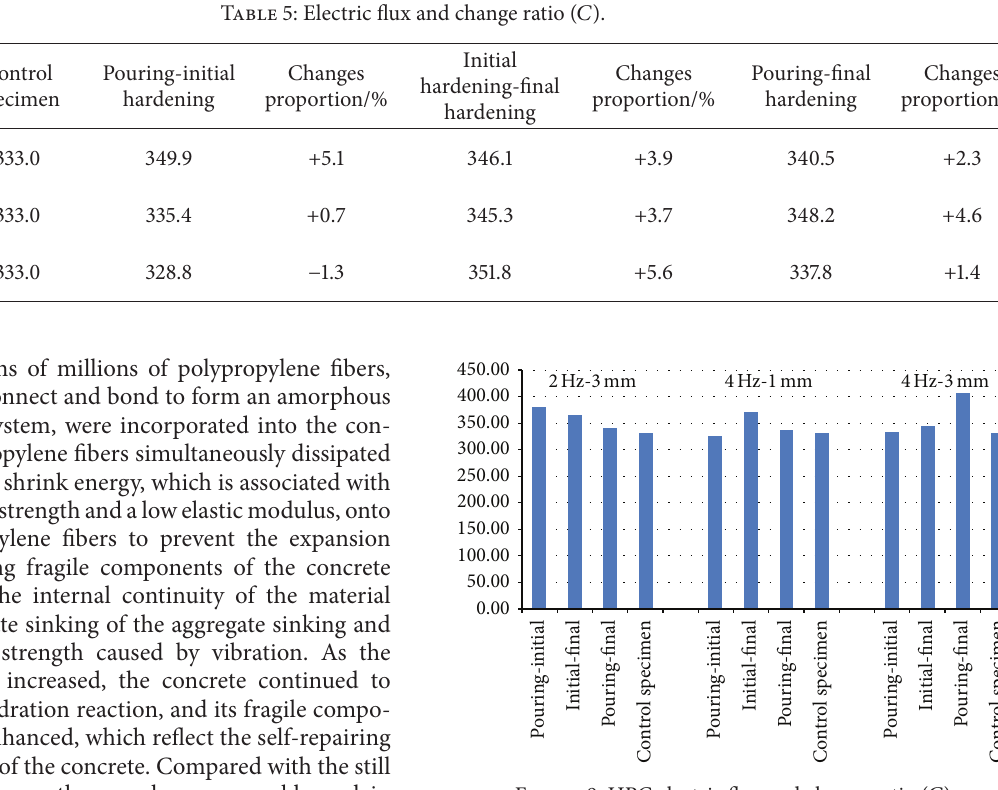
Figure 9: HPC electric flux and change ratio ( 𝐶